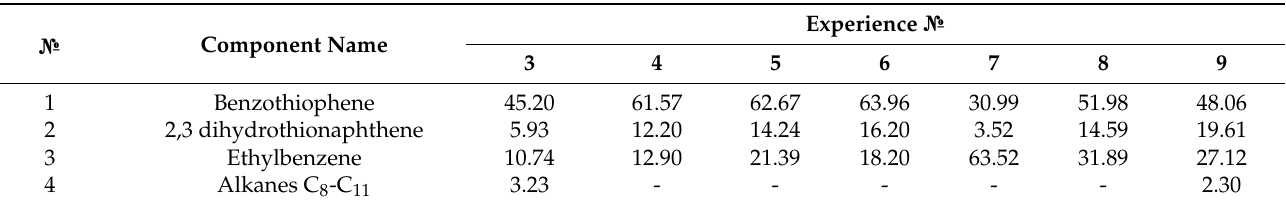
Table 8. Individual chemical compositions of the hydrogenates obtained under the various conditions of the benzothiophene hydrogenation